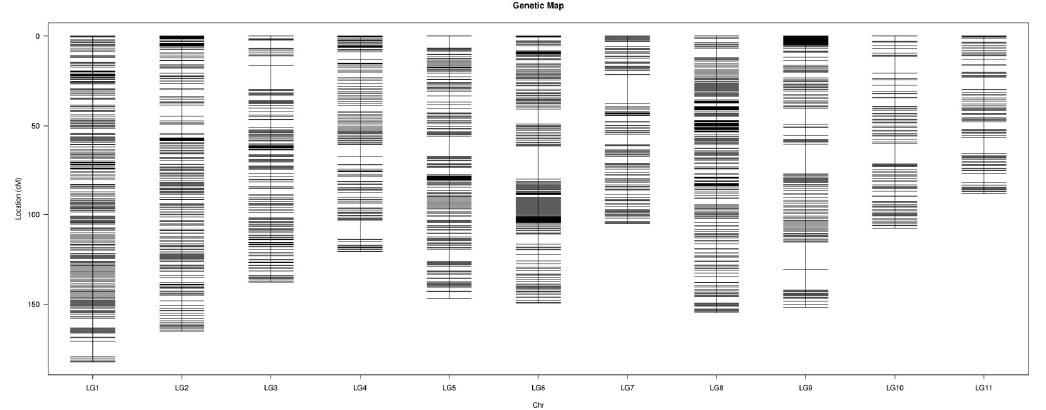
Figure 2. High-density genetic map of watermelon constructed by bin markers. Haplotype and heat maps were used to assess the quality of our genetic map. The haplotype map reflected the double crossovers of the population and deletions, which indicated recombination events and marker ordering errors. Haplotype maps were generated for each of the 126 lines in the RIL population as well as the parental lines. As illustrated in Figure 3, almost all of the recombination blocks were clearly defined.